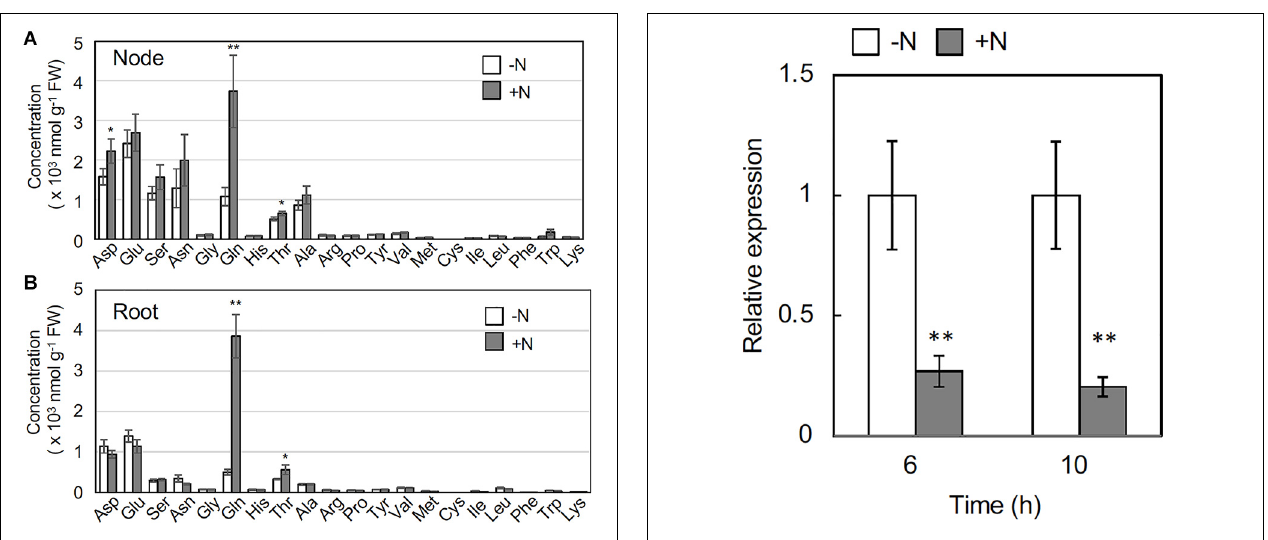
FIGURE 4 | Effects of nitrogen application on amino acid concentrations in rhizome nodes and roots. Young ramets having rhizomes at a similar growth stage were hydroponically grown in a low-N (200 µ M NH 4 NO 3 ) medium for 2 weeks. The ramets were subsequently transferred to culture media containing no nitrogen (-N) or 2 mM NH 4 NO 3 (+N) and incubated for 2 h. Rhizome nodes and roots were separately harvested and subjected to amino acid analysis. The amino acid concentrations in nodes including axillary buds (A) and roots (B) . Data are presented as the mean ± S.E. ( n = 3). * P < 0.05; ** P < 0.01 (Student’s t test) compared to the -N treatment. FW, fresh weight.